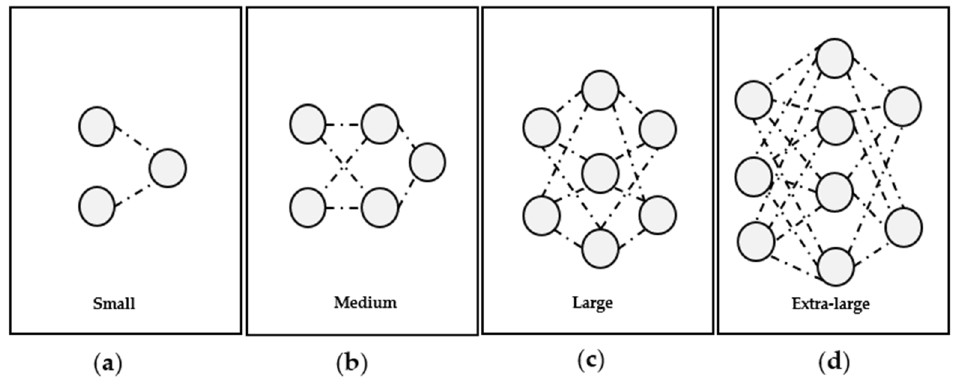
Figure 3. Deep learning architecture model used convolutional neural network (CNN). Figure 4. YOLOv5 architectural size of the neural network model: Small-YOLOv5s ( a ), Medium- YOLOv5m ( b ), Large-YOLOv5l ( c ), and Extra-large-YOLOv5x ( d ).